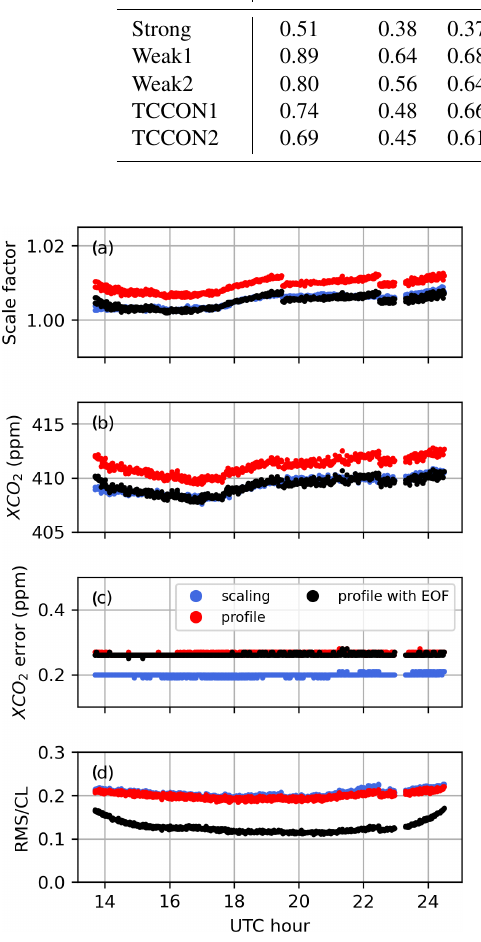
Figure E2. Quantities derived from retrievals on East Trout Lake measurements on 29 March 2018 for the Strong window. The re- trieval type is indicated by the legend. Panel (a) shows the column- integrated CO 2 scale factor. Panel (b) shows XCO 2 and panel (c) shows the XCO 2 error. Panel (d) shows the root mean square of the residuals as a fraction of the continuum level.